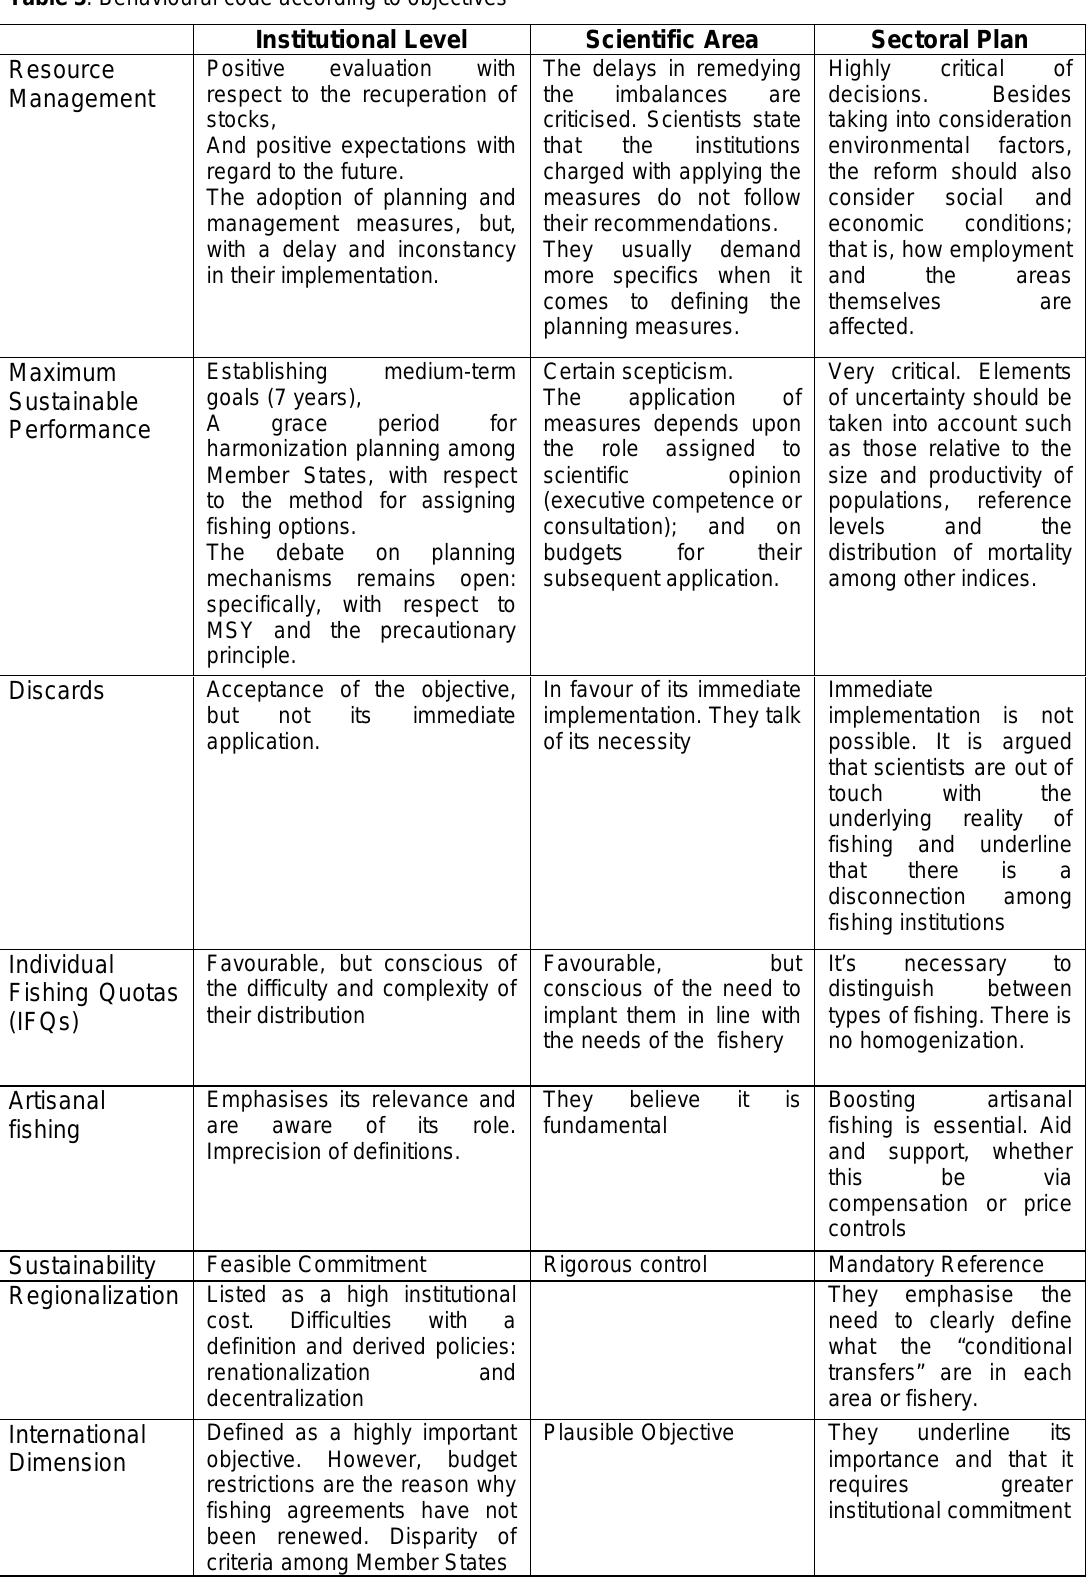
Table 3 . Behavioural code according to